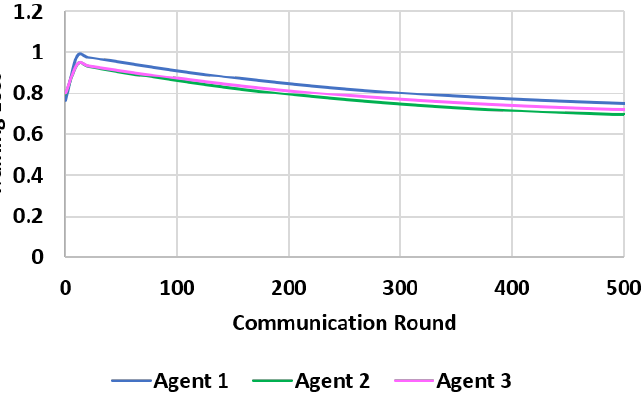
Figure 15. FedResilience’s impact on participating FL agents’ (three agents and two stragglers) model loss for the prediction of CIA